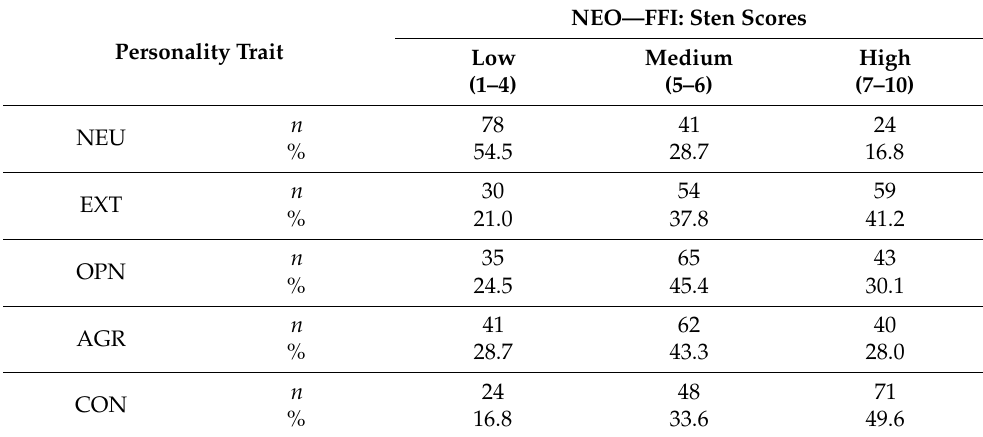
Table 3. Percentage sten distribution in particular traits in the examined population.